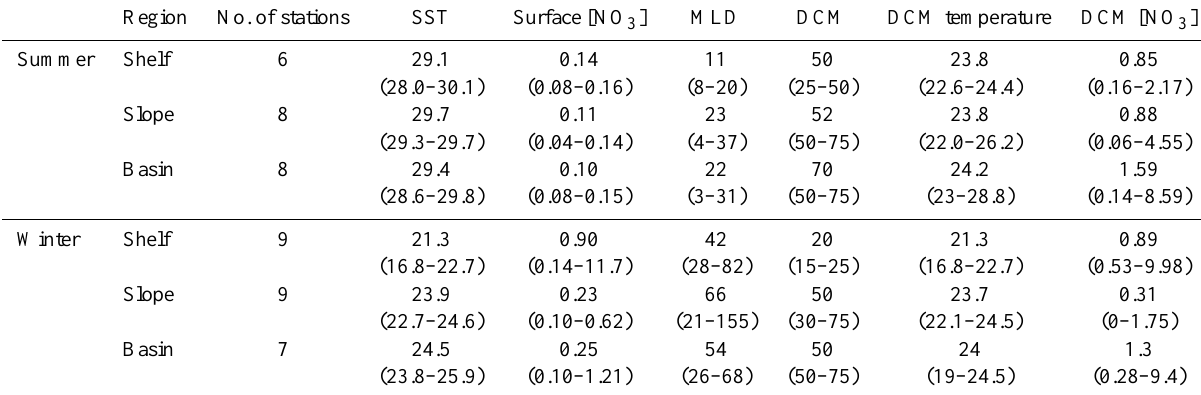
Table 1. Background information on physical and chemical parameters of experimental stations. The stations are grouped based on bathymetry (see text for details). SST: sea surface temperature ( ◦ C). [NO 3 ]: nitrate concentration (µmolL − 1 ) . MLD: mixed layer depth (m). DCM: depth of deep chlorophyll maximum (m). The numbers without parentheses are median values and the numbers in parentheses indicate the minimum to maximum of the